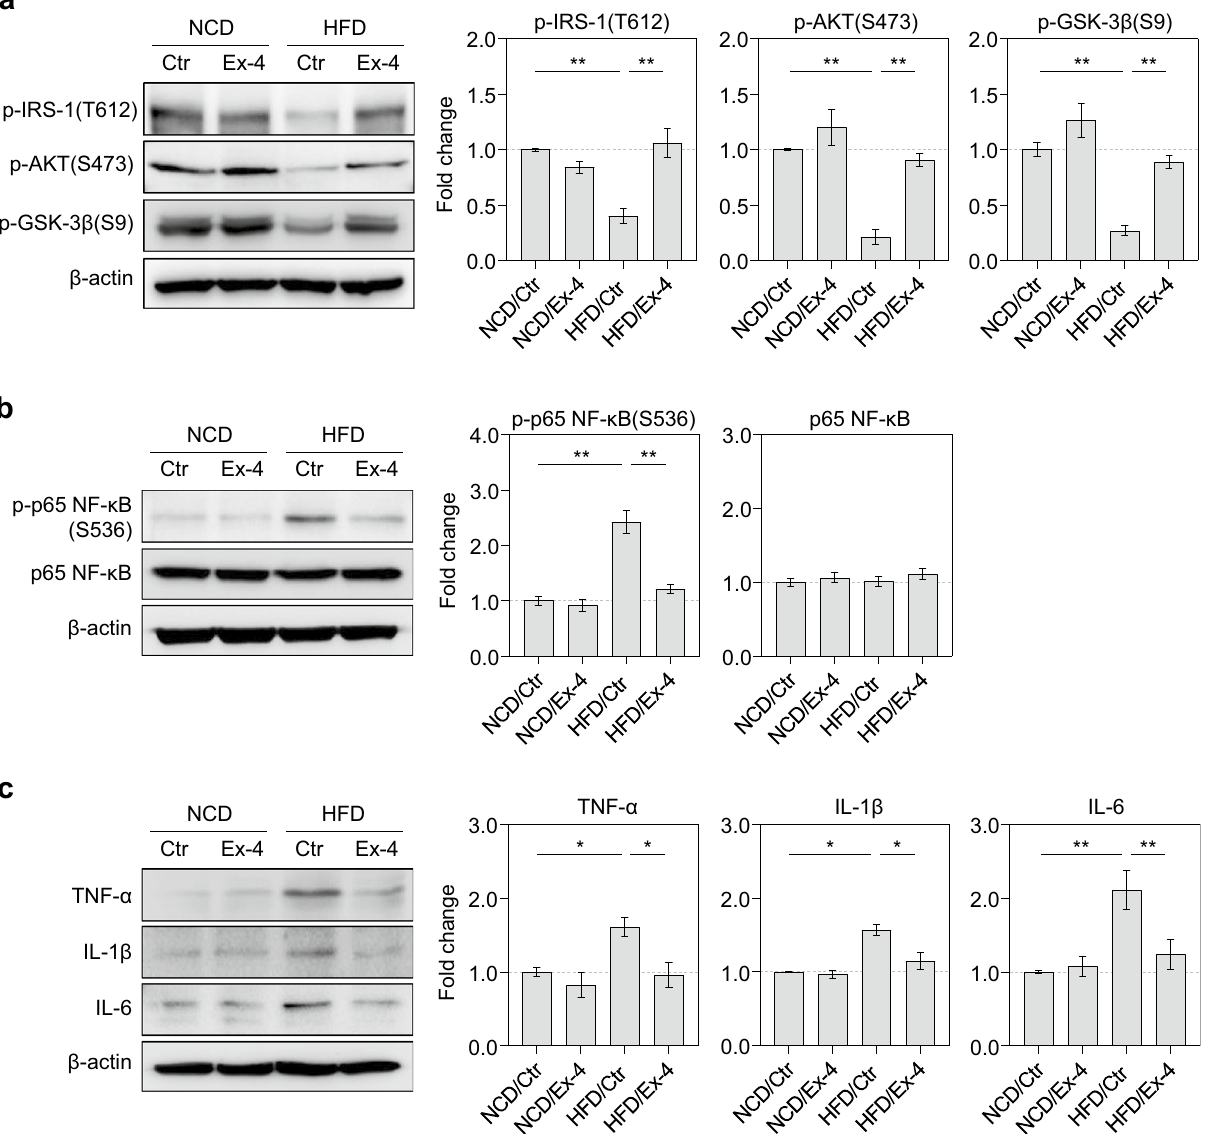
Figure 4. Exendin-4 ameliorated insulin resistance and suppressed neuroinflammation in the HFD mice brain. ( a ) p-IRS-1 (T612), p-AKT (S473), p-GSK-3β (S9) protein levels in the hippocampus between the control and exendin-4 groups in either NCD or HFD-fed mice evaluated by western blot analysis and quantified by densitometric analysis, n = 4, equal to the number of animals. ( b ) p-p65 NF-κB (S536) and p65 NF-κB protein levels in the hippocampus between the control and exendin-4 groups in either the NCD or HFD mice evaluated by western blot analysis and quantified by densitometric analysis, n = 4, equal to the number of animals. ( c ) TNF-α, IL-1β, and IL-6 protein levels in the hippocampus between the control and exendin-4 groups in either the NCD or HFD-fed mice evaluated by western blot analysis and quantified by densitometric analysis, n = 3–4, equal to the number of animals. Data information: Ctr.: control; Ex-4: exendin-4; NCD: normal chow diet; HFD: high-fat diet. Data are expressed as the group mean ± standard error of the mean. Data are expressed from three or four independent experiments in triplicate. Statistical analyses examined the relative significance between each group by ANOVA with post-hoc Tukey HSD Test or Games-Howell Test. Differences were considered significant at *P < 0.05, **P <